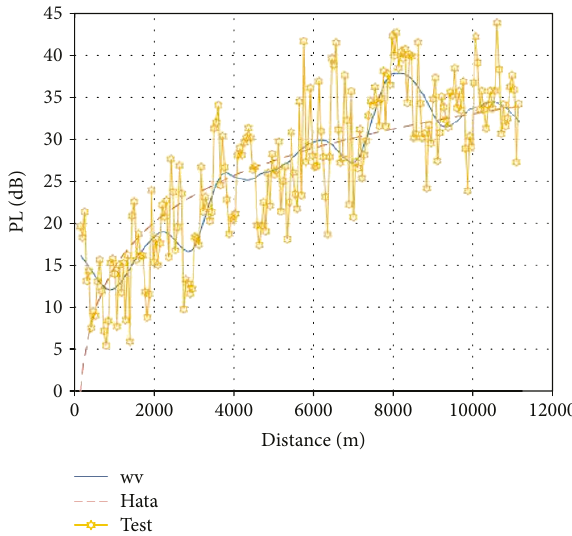
Figure 4: Propagation loss versus distance. wv: wavelet method using db7 and level 6; Hata: optimized Hata model; test: measurement data.